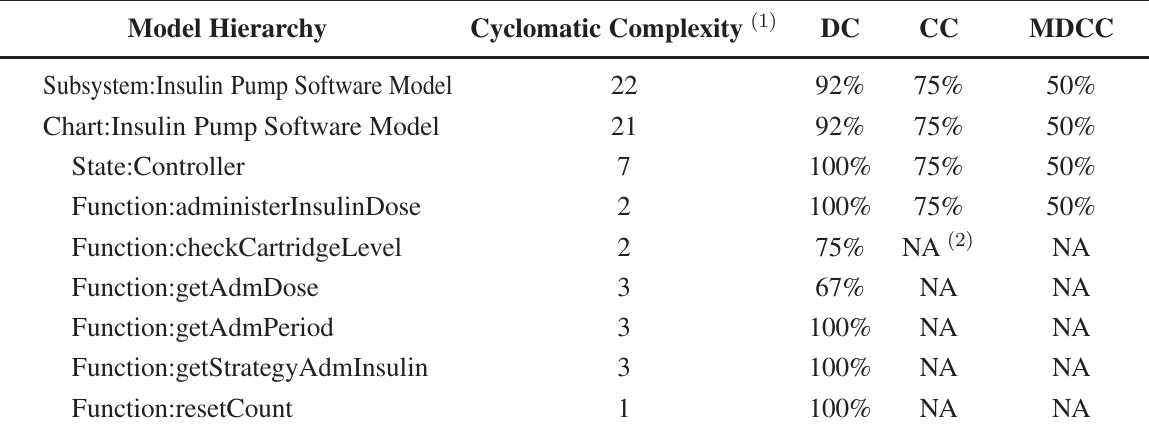
Table 5. Summary of the Coverage Report for Insulin Pump Software Model. Model Hierarchy Subsystem:Insulin Pump Software